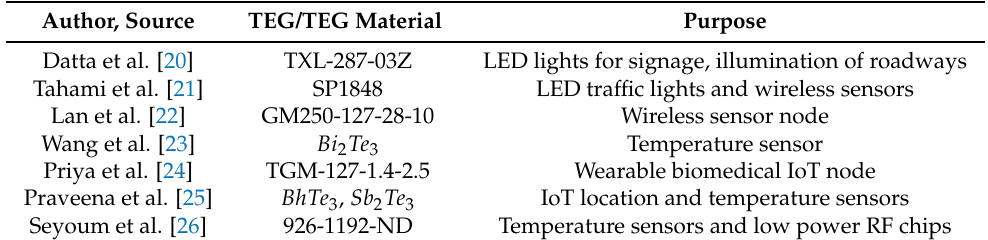
Table 1. Summary of TEG used in outdoor applications.